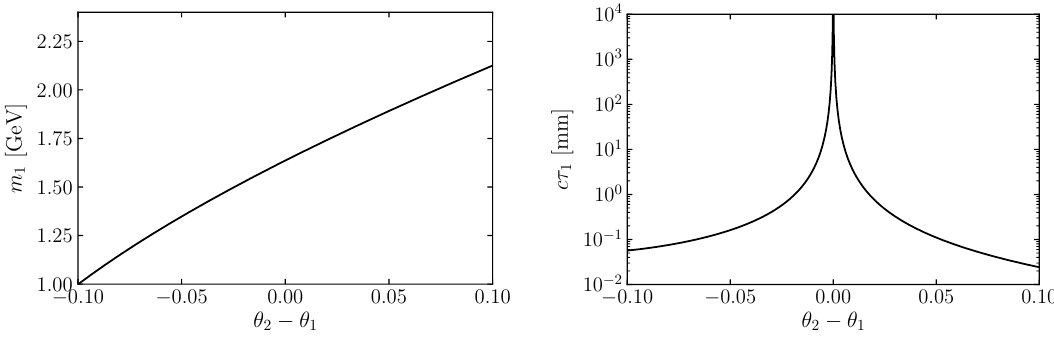
Figure 8 . The lightest scalar mass (on the left) and its flight distance (on the right) as a function of the Z 2 breaking parameter associated to the a 1 particle. It is assumed that θ 1 = 1 . 1